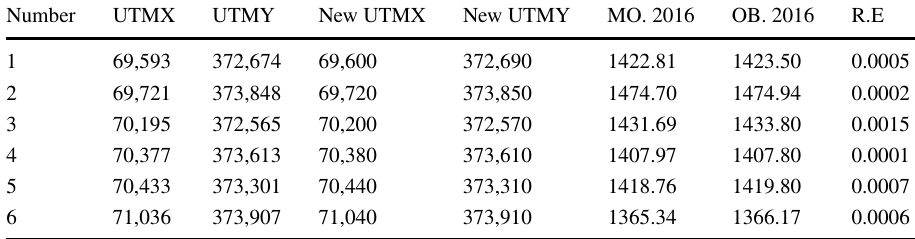
from the model and observed values